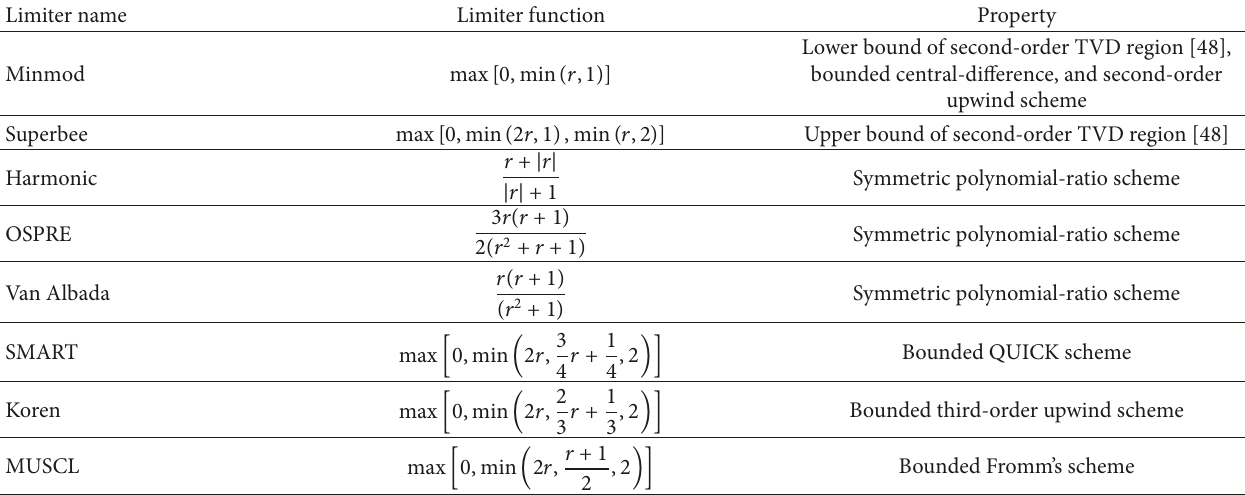
Table 2: Flux limiter scheme based on TVD.